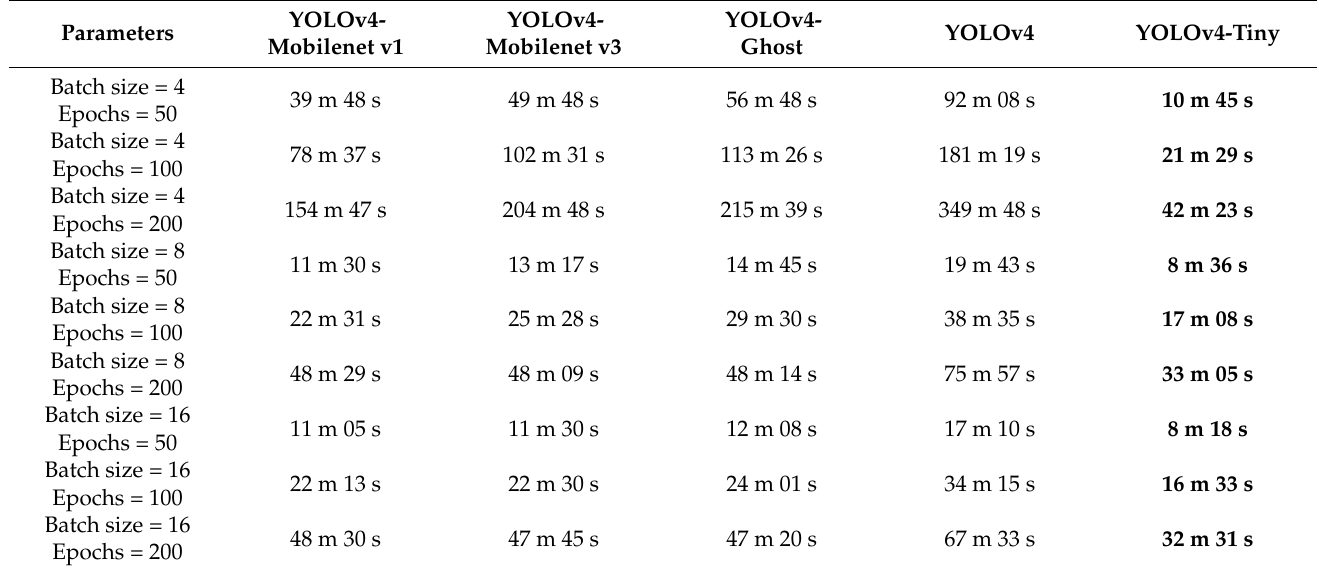
Table 2. Comparison of the training time of different models.